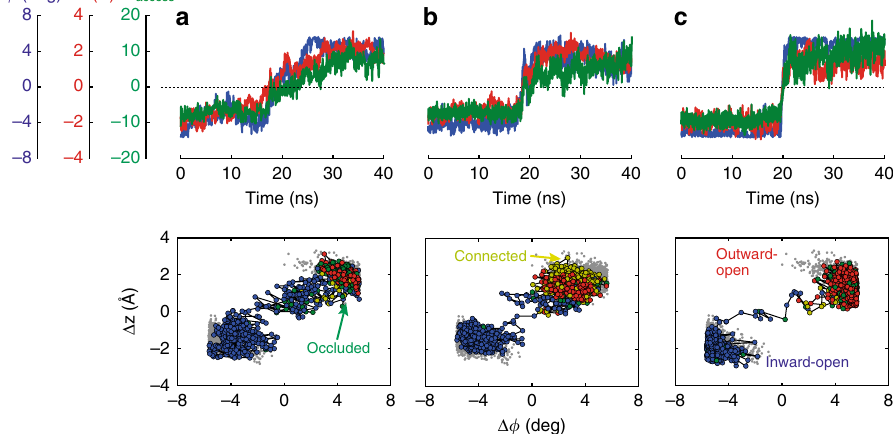
Fig. 2 Proton- and sodium-transport transition paths. Representative transition paths for a H + transport and b Na + transport at 37 °C, and c Na + transport at 100 °C. The transition-path trajectories are projected onto the two order parameters for rotation and translation of the six-helix-bundle motion, Δ ϕ and Δ z . (Top) Time series of the structural order parameters (blue: Δ ϕ ; red: Δ z ), and the hydration order parameter n equilibrium runs (gray) and transition paths onto the Δ ϕ - Δ z plane. Inward-open, occluded, connected, and outward-open states are shown as blue, green, yellow, and red points, ( n access < 0). Occluded and connected states have n access ≈ 0. The paths share a remarkably rapid transition (~10 ns) through the in local structure and water access state fl anking the actual transition. The transition states (i.e., con fi gurations from which we successfully shot off transition-path trajectories) are inter- mediate between the metastable states (Supplementary Table 1).